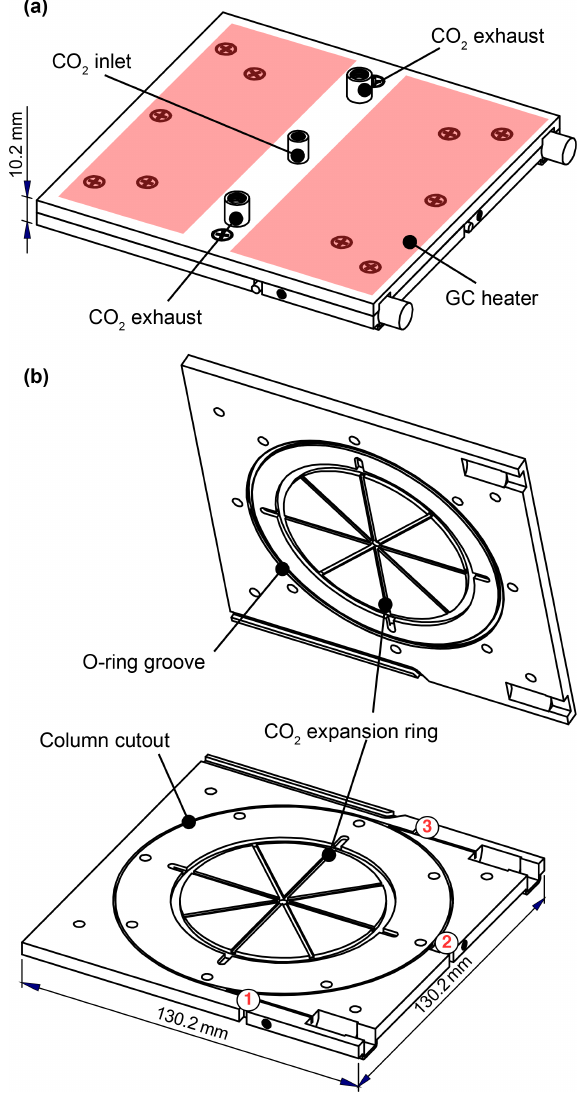
Figure 2. Schematic of the GC cryotrap and heating unit. Column sits in a groove machined into one plate, providing good thermal contact. CO 2 enters from the center of both plates and expands in the eight radial spokes before exiting through four exhaust ports. Heaters are adhered to the outside of the GC assembly; two of these heaters are shown above in red. The temperature is measured at three locations near the column: (1) near the inlet of the column, (2) on the column ring, and (3) near the outlet of the